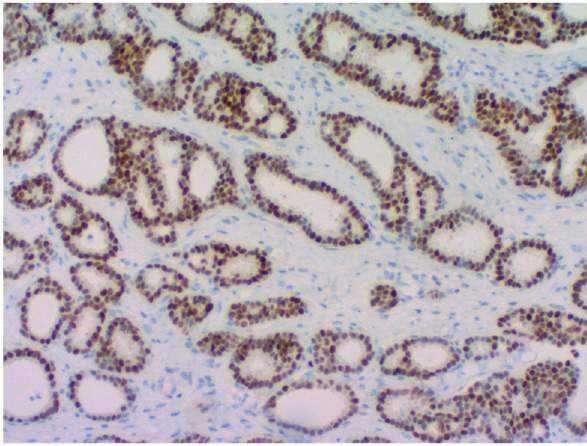
Figure 4. Oestrogen receptors diffusely expressed in the breast carcinoma (estrogen receptor (ER) immunohistochemistry, X200 magnification).